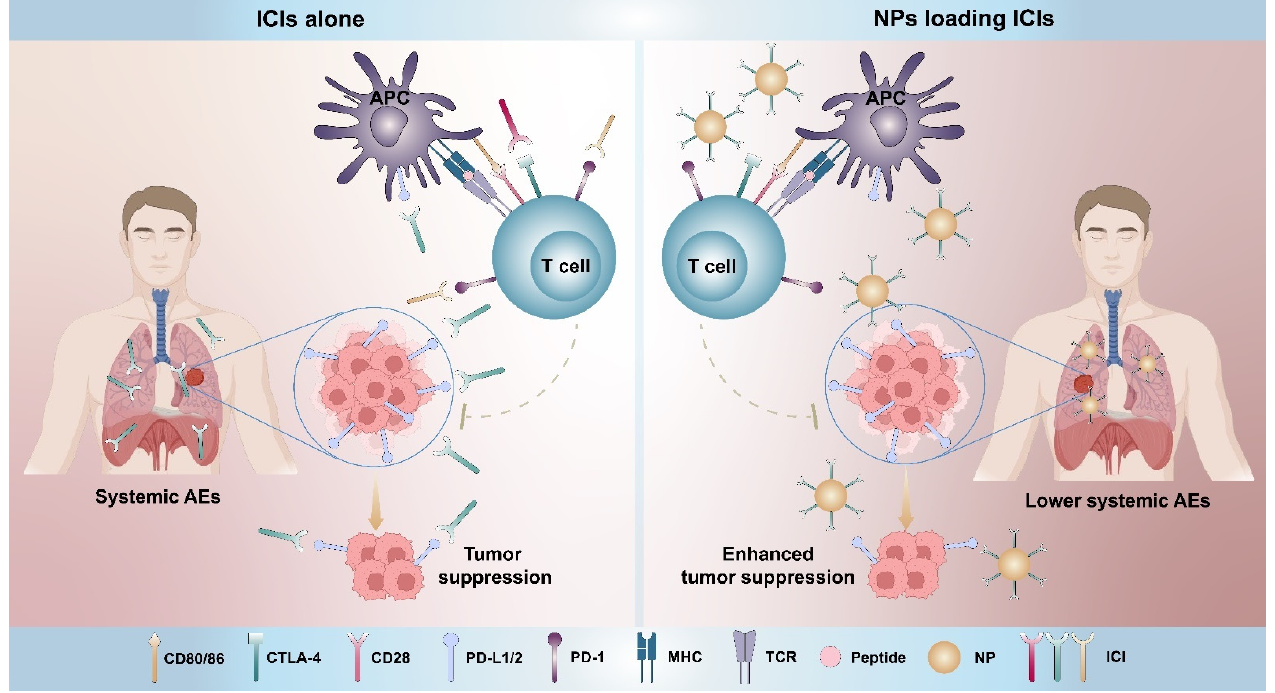
Figure 1. A comparison of ICIs alone and NPs loading ICIs. The application of ICIs leads to the activation of tumor-specific T cells by blocking PD-1 and CTLA-4 on T cells and also PD-L1/2 on tumor cells or APCs as well. The administration of ICIs alone over-stimulates the immune system and increases the possibility of off-target effects which is the cause of systemic AEs. By contrast, NPs loading ICIs leads to a high local concentration of ICIs in the tumor site while reducing the off-target side effects.